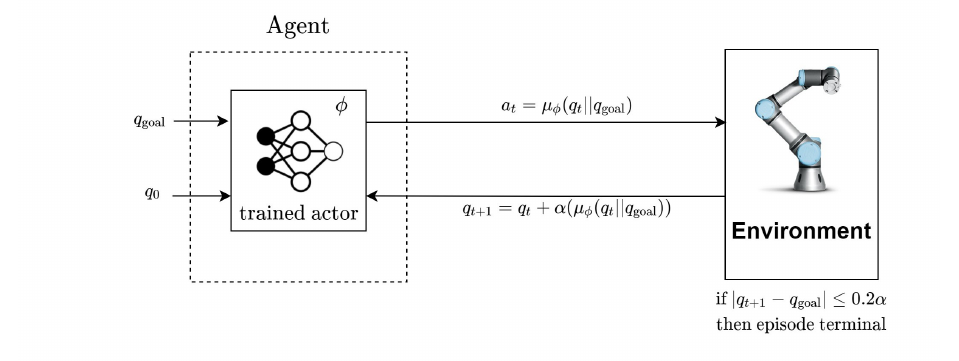
Figure 6. Path generation using the trained actor